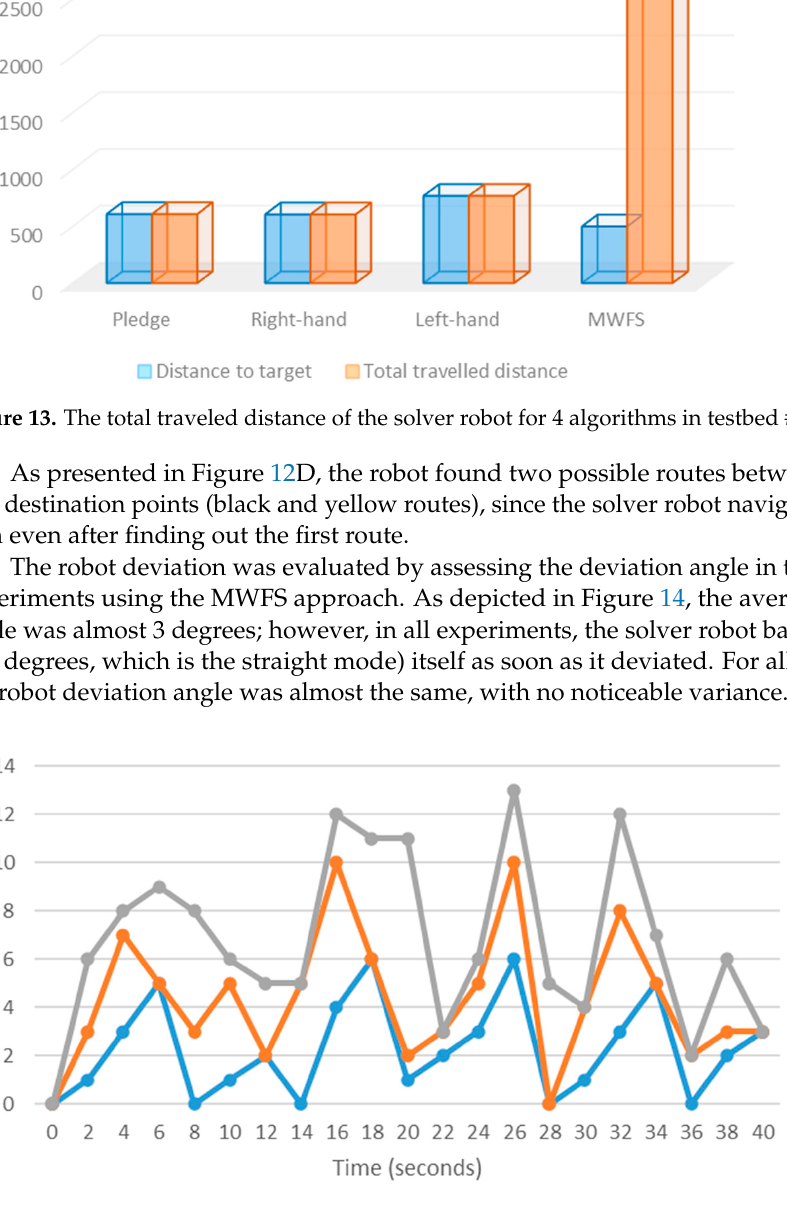
Figure 12. The route of the solver robot using 4 algorithms in testbed # 3. ( A ) Pledge algorithm; ( B ) right-hand algorithm; ( C ) left-hand algorithm; ( D ) MWFS.